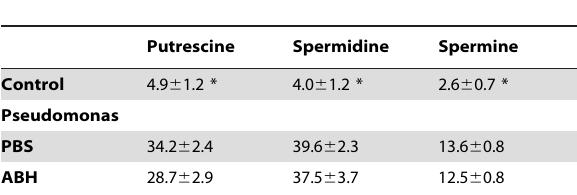
Table 1. Concentrations ( m mol/L) of the L-ornithine derived polyamines putrescine, spermidine and spermine in lung homogenates of naı¨ve control and Pseudomonas infected mice treated with PBS or arginase inhibitor ABH.